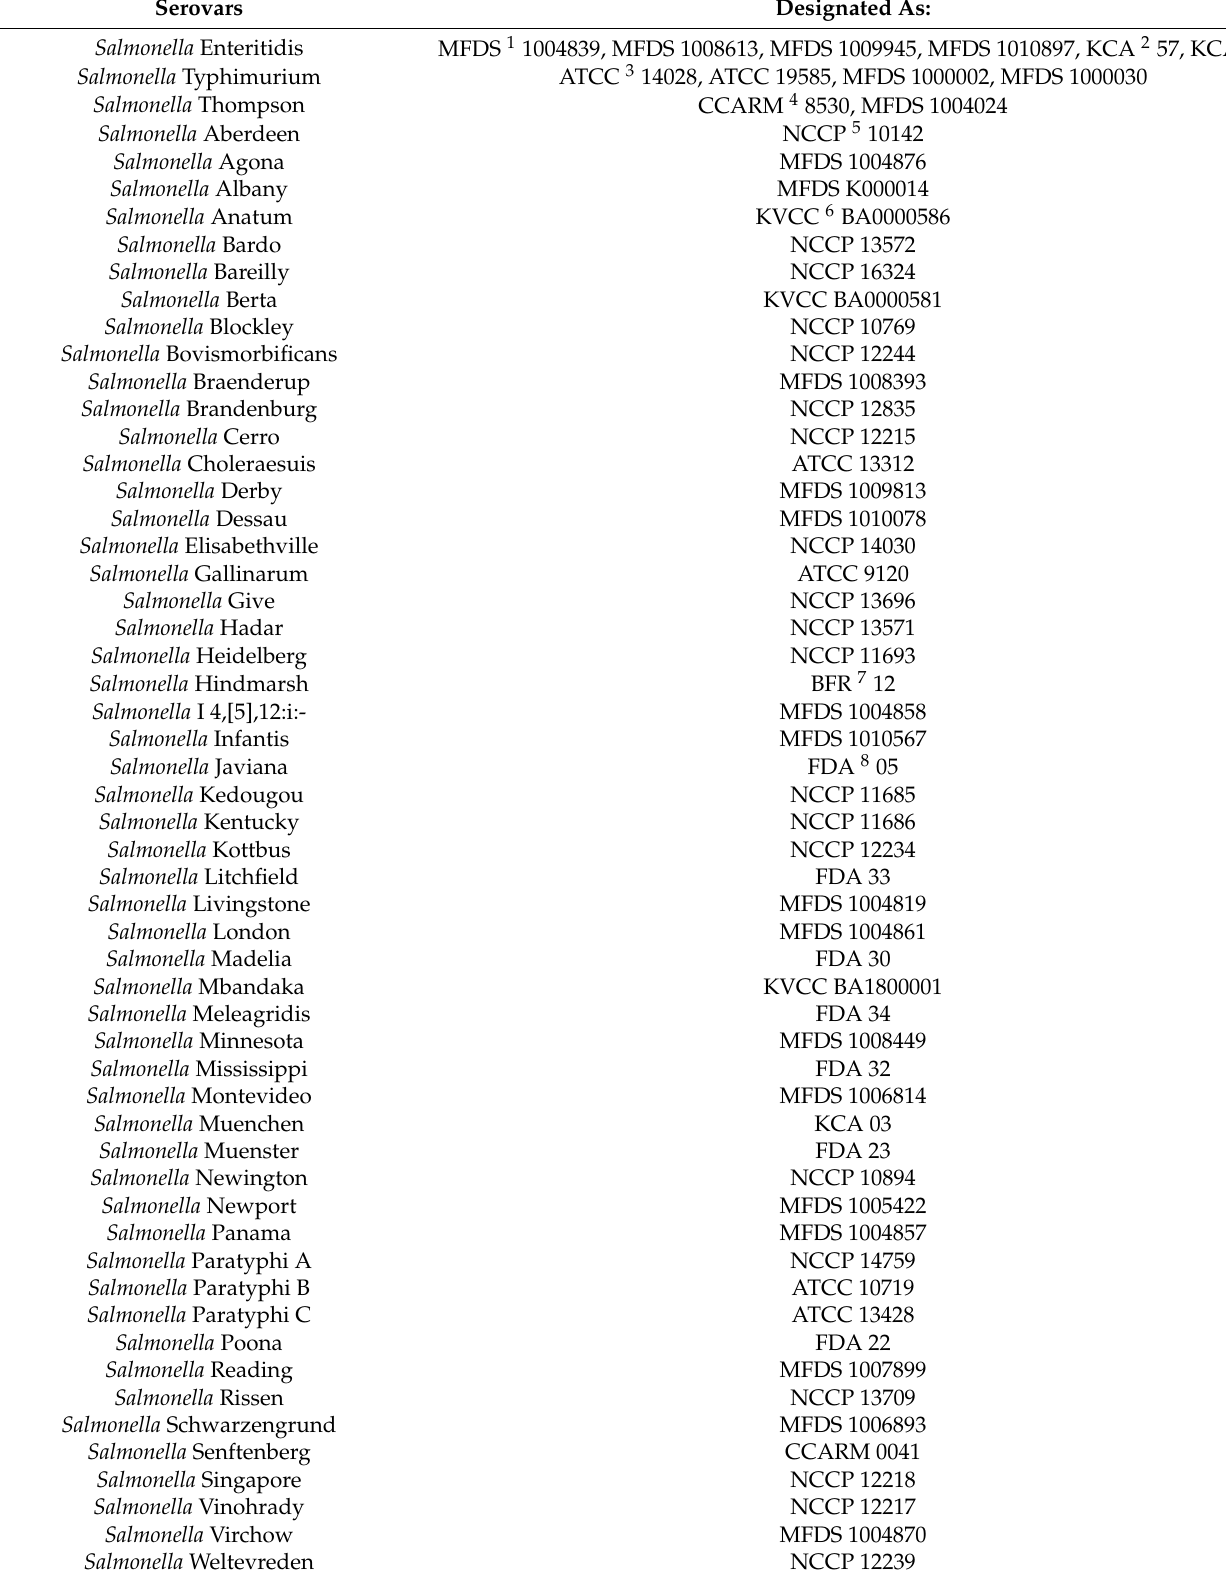
Table 1. List of Salmonella reference strains used in this study.